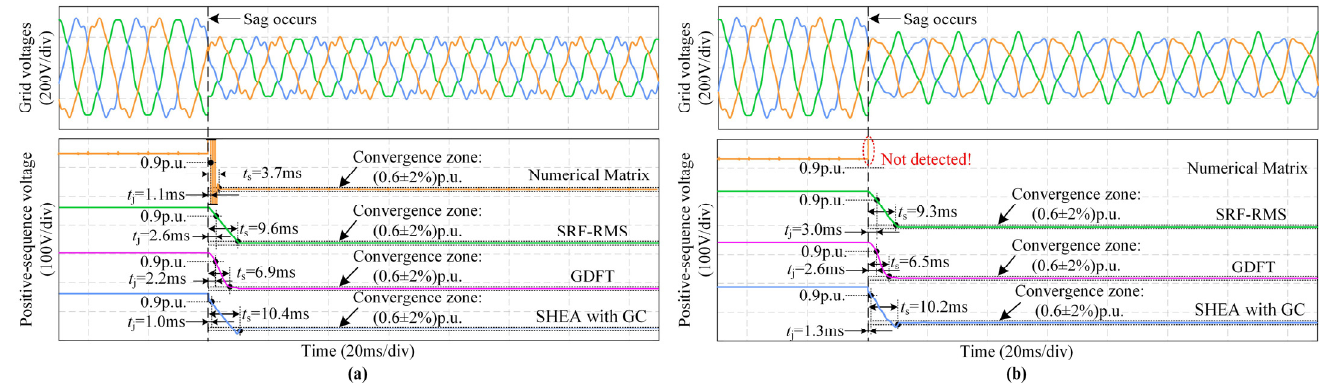
Figure 12. The results of different voltage detection methods (numerical matrix, SRF-RMS, GDFT, SHEA with GC) under different working conditions: ( a ) symmetrical sag; ( b ) symmetrical sag with high-frequency noise.